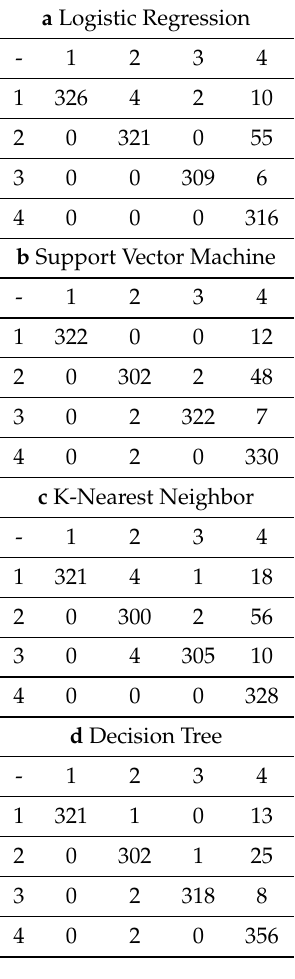
Table 10. Confusion matrices of different machine learning methods for two people. a Logistic